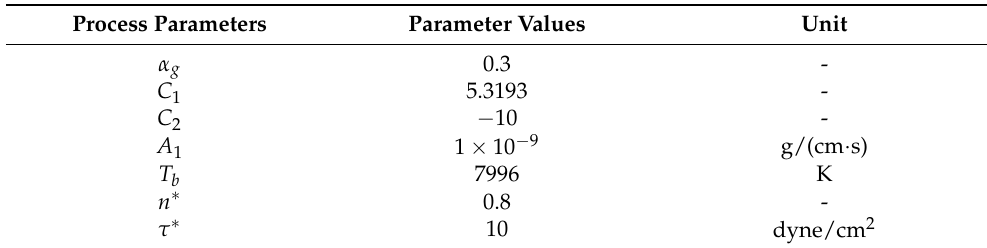
Table 1. Values of the Cross–Castro–Macosko model constants. The constants were measured by a parallel-plate rheometer.